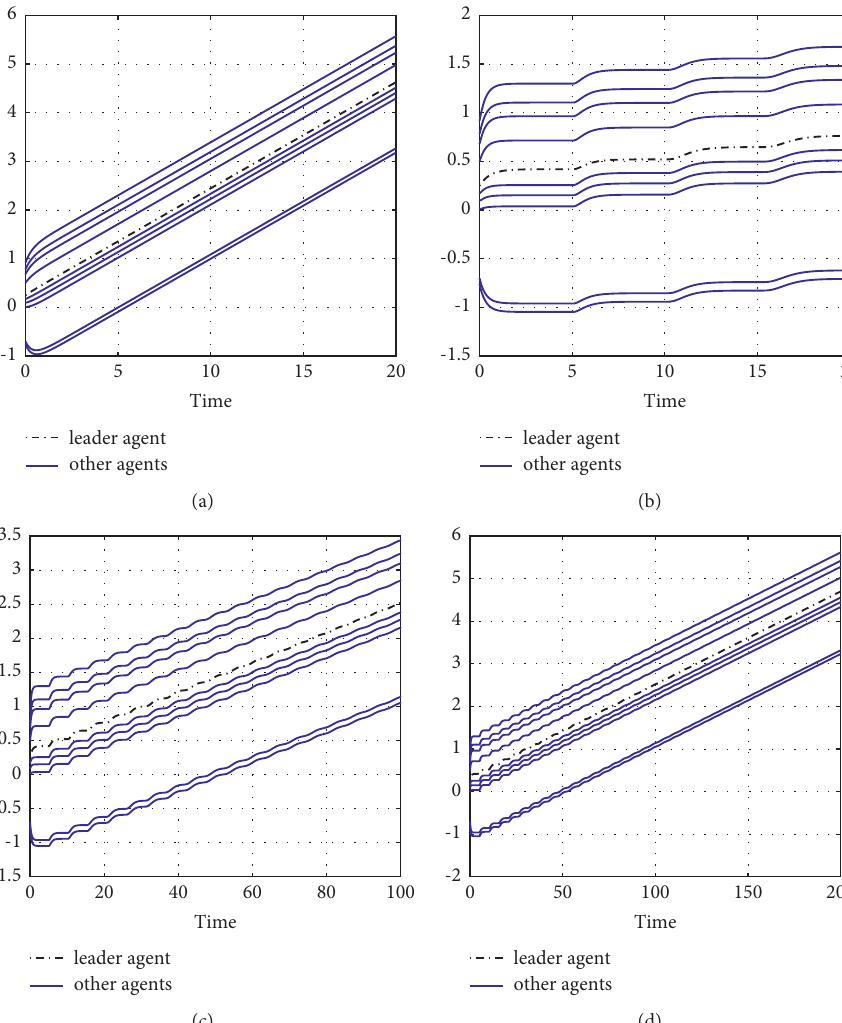
Figure 1: Simulation of the CS model with one leader and nine followers. (a) shows the trajectories of agents where the motion has no delay. (b)–(d) present the trajectories of agents where the movement of flocks have an effect of time delay ( τ � 5) in time t � [ 0 , 20 ] , t � [ 0 , 100 ] , and t � [ 0 , 200 ] , respectively. Note that the dashed line represents the trajectory of the leader, while the blue line denotes the trajectory of the follower. (a) Without time delay for t ∈ [ 0 , 20 ] . (b) With delay ( τ � 5) for t ∈ [ 0 , 20 ] . (c) With delay ( τ � 5) for t ∈ [ 0 , 100 ] . (d) With delay ( τ � 5) for t ∈ [ 0 , 200 ]